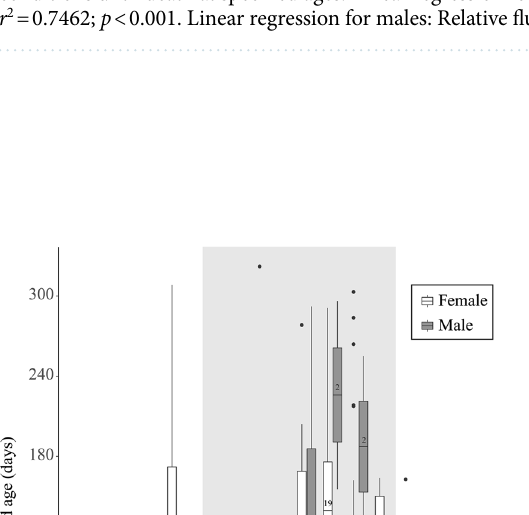
Figure 1. Pterin relative fluorescence (in thousands) of female and male P. downsi adults held under laboratory conditions until death at specified ages. Linear regression for females: Relative fluorescence = 0.21*Age + 18.46;